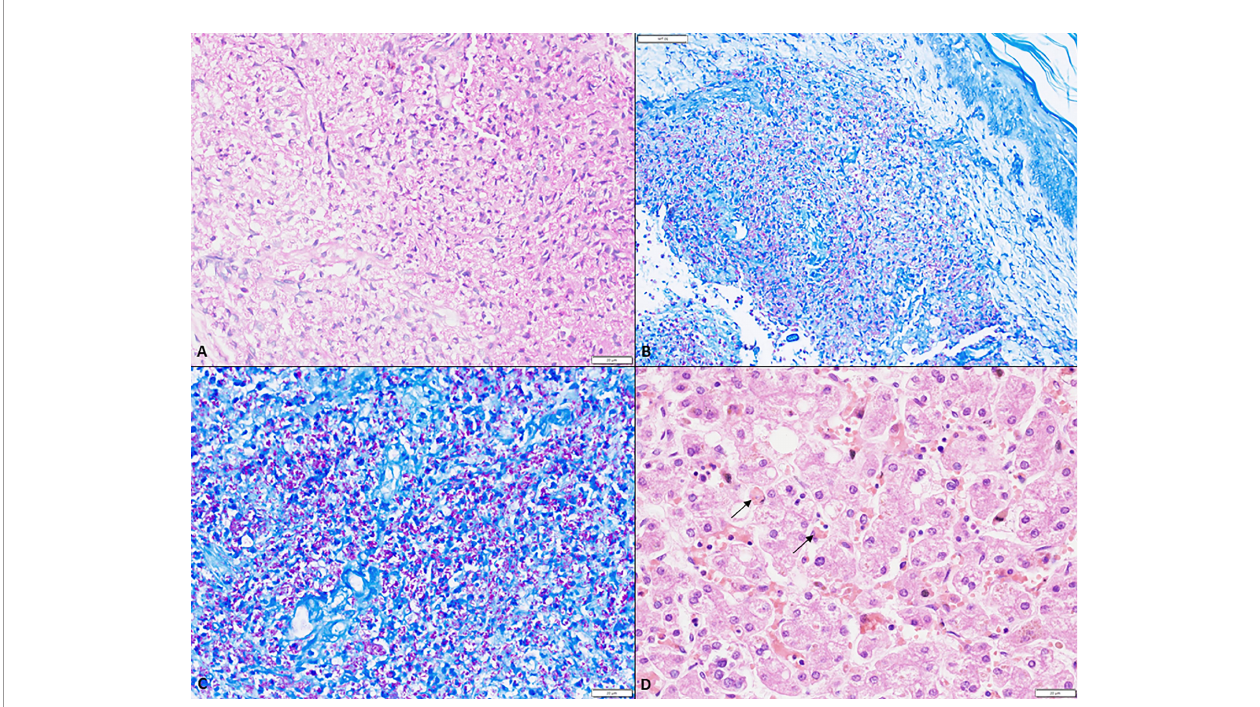
FIGURE 1 | (A) A large collection of foamy macrophages in the dermis (scale bar 20 µm); (B) low magni fi cation depicting numerous acid-fast bacilli within the foamy cells in the dermis (ZN, scale bar 50 µm); (C) Numerous acid fast bacilli within the dermis both intra- and extra-cellularly (ZN, scale bar 20 µm); (D) Hemophagocytosis within Kupffer cells in the sinusoids (arrow) (H&E, scale bar 20